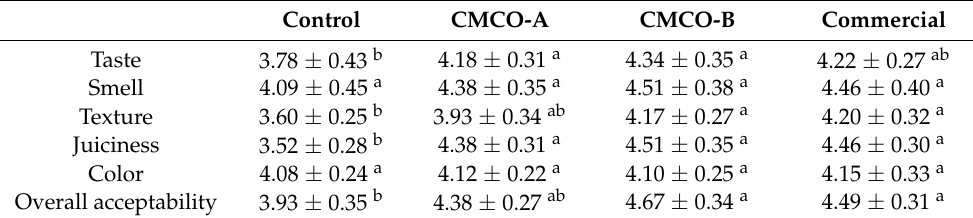
Table 1. Effect of CMCO on sensory attributes of the gels prepared from frozen surimi after 60 days of storage. Control CMCO-A CMCO-B Commercial Taste 3.78 ± 0.43